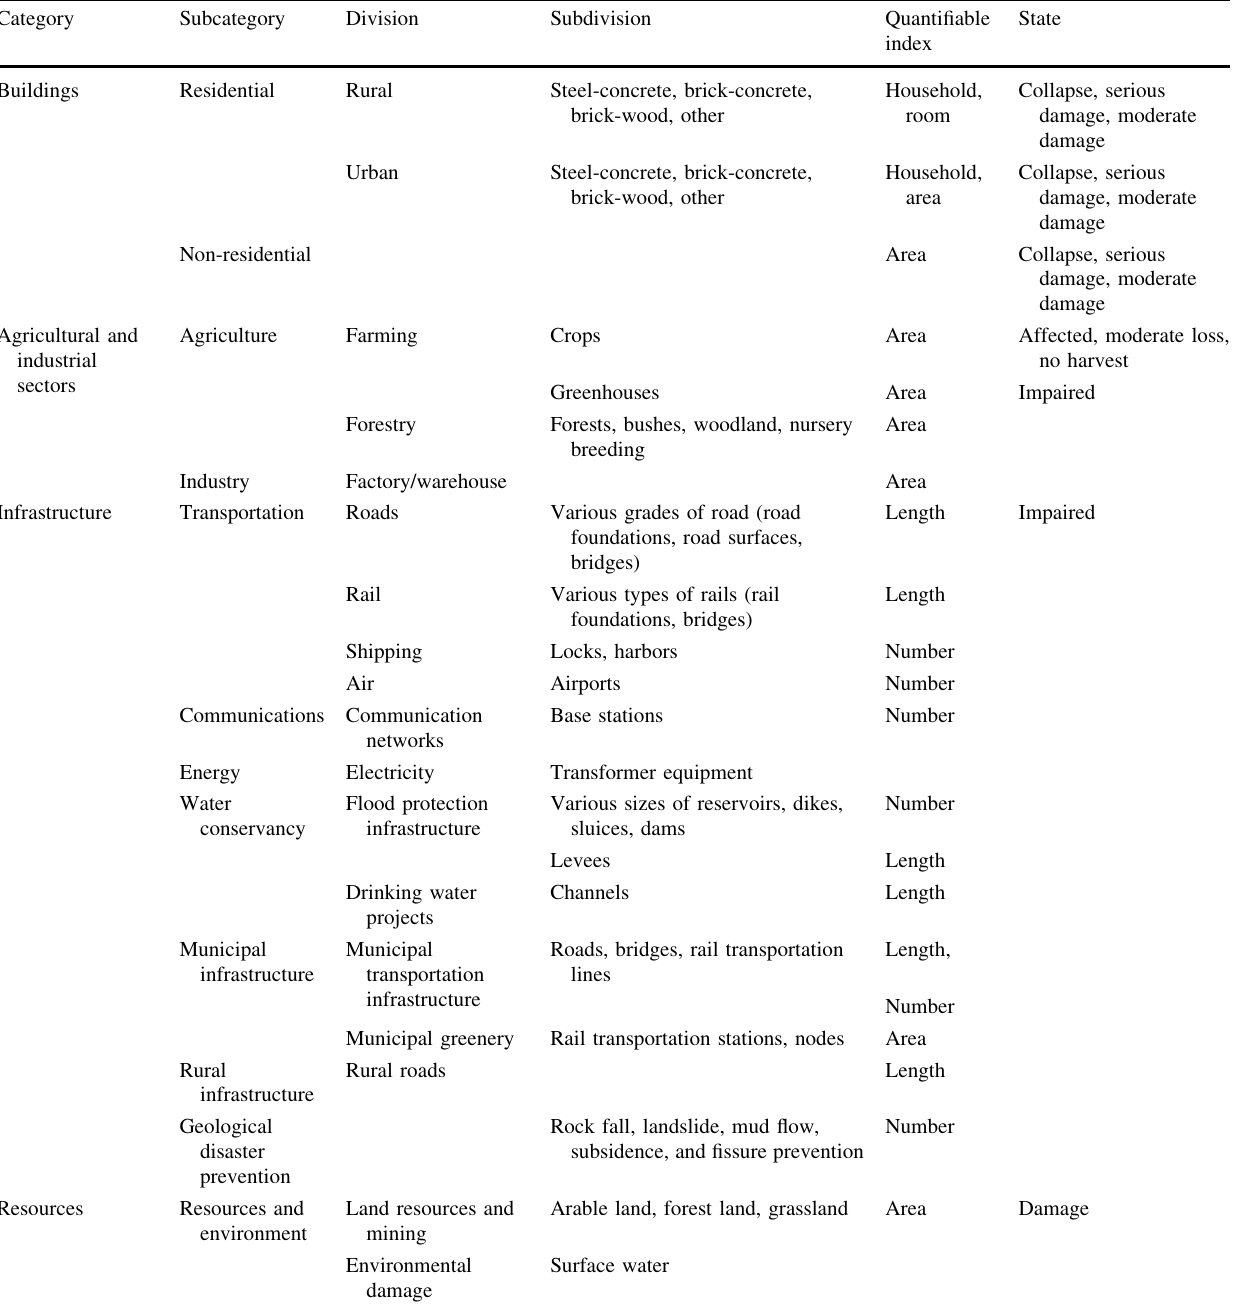
Table 1 The index system for quantitative assessment of disaster physical damage using remote sensing data developed in